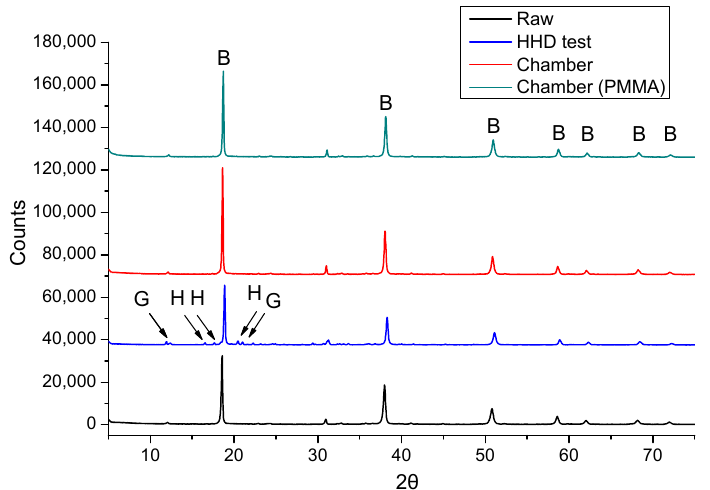
Figure 10. XRD overlay diffractograms of coated specimens after 4 days of different acid spraying tests’ application (the raw material is also presented); B: Brucite, G: Gypsum, H: Hexahydrite.